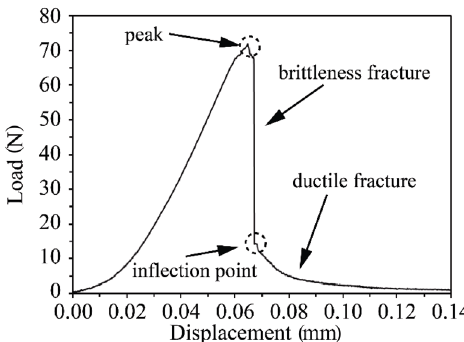
Fig. 9 A typical load–displacement curve of co-continuous composites (sintering at 1480 ℃ ) in fracture toughness test.